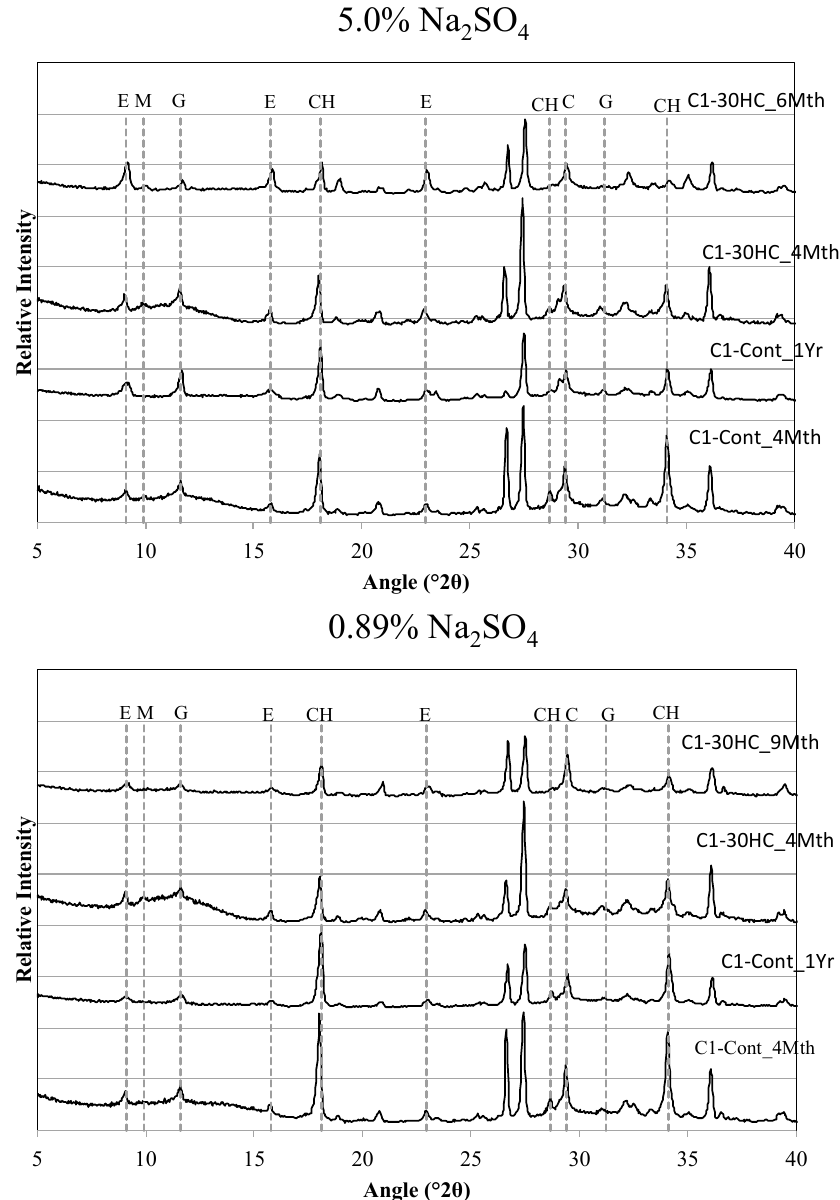
Figure 10. XRD traces of control (C1-Cont) and binary (C1-30HC) mixtures. The percentages of hydration products were determined using rutile (TiO 2 ) as an internal standard and are presented in Figure 11a–c. Ettringite and gypsum phases were present at similar quantities at about 56 days independent of sodium sulfate concentration; however, after one year exposure the ettringite is the dominant phase present with